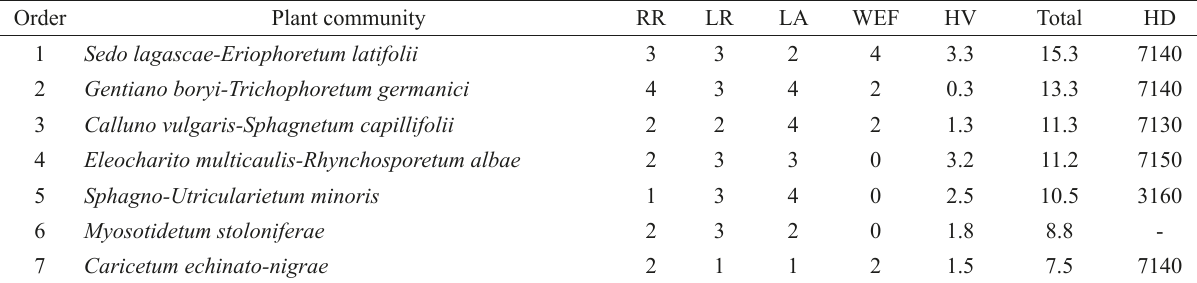
Table 11. Cumulative point-scoring ranking of peatland plant-communities in the Gredos Regional Park after application of the five criteria (RR regional responsibility; LR local rarity; LA local abundance; WEF wealth of its endangered flora; H habitat vulnerability) and their adscription to habitat codes from Habitat Directive (HD).